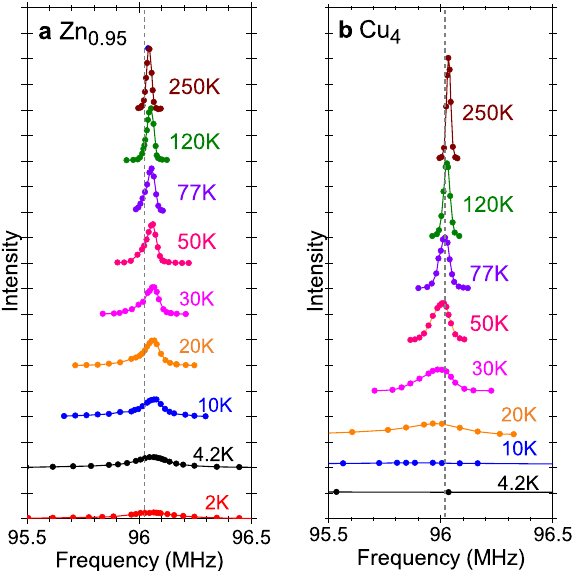
Fig. 2 19 F NMR lineshapes. Representative 19 F NMR lineshapes of a "Zn 0.95 ” (Zn 0.95 Cu 0.05 )Cu 3 (OD) 6 FBr and b “ Cu 4 ” Cu 4 (OD) 6 FBr, both measured in B ext = 2.4 T and normalized for Boltzmann factor. For clarity, the vertical origin is shifted at different temperatures. The lineshapes of Cu 4 below T N = 15 K is extremely broad due to the static hyper fi ne magnetic fi eld from ordered Cu moments. The gray vertical dashed line represents the bare resonance frequency 19 f 0 with no Knight shift.